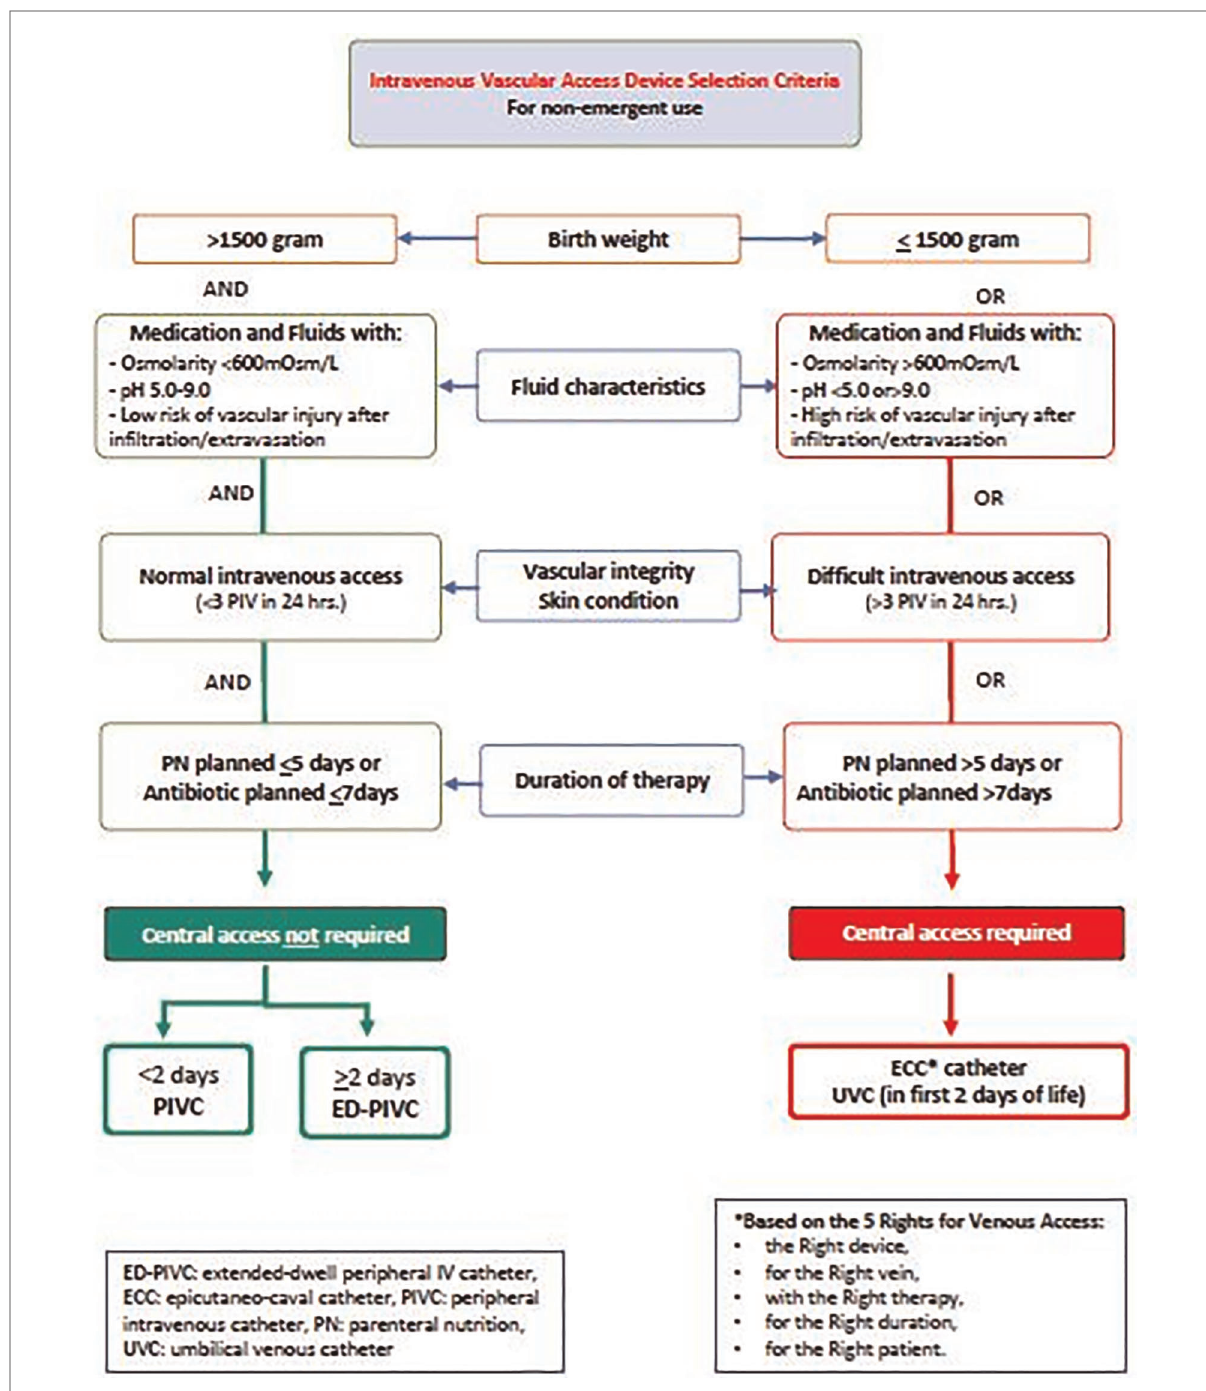
FIGURE 1 Vascular access device decisional algorithm. ECC, epicutaneo-caval